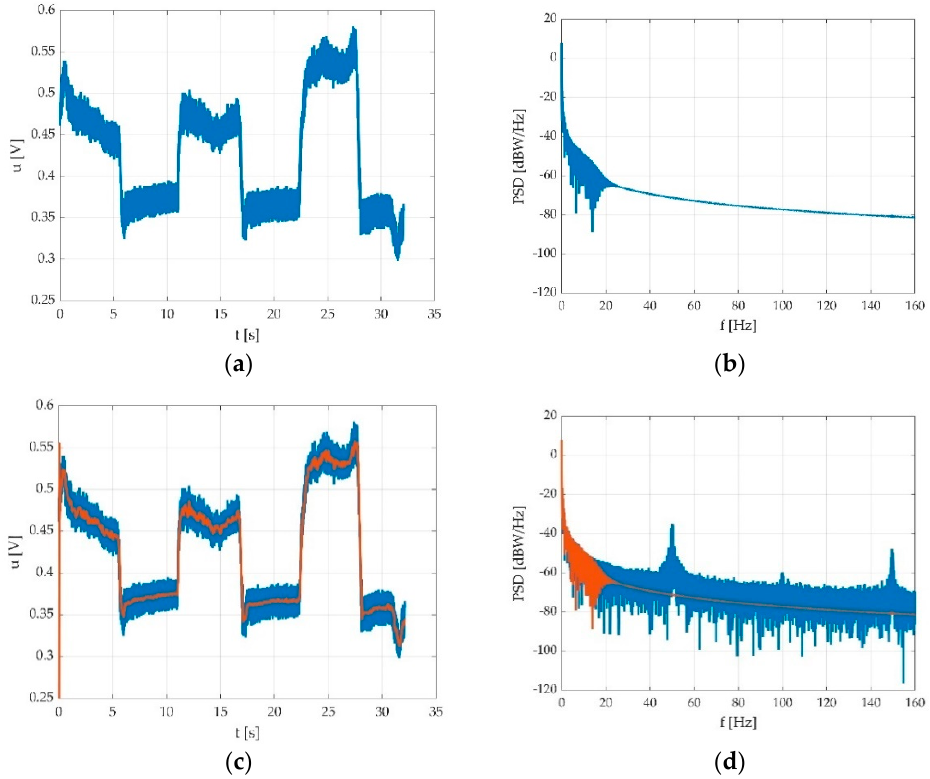
Figure 9. Results after applying the low pass filtering: ( a ) signal after filtering; ( b ) signal spectrum after filtering; ( c ) overlap between original (blue) and filtered (red) signal; ( d ) overlap between original spectrum (blue) and spectrum after filtering (red).